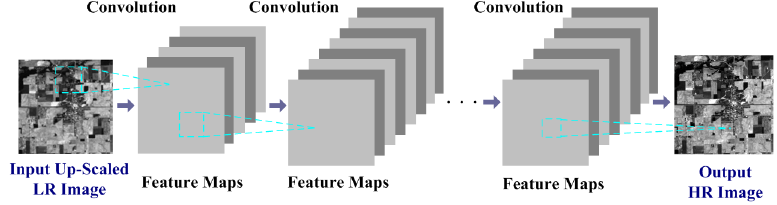
Figure 1. A typical CNN architecture for super-resolution of single image.